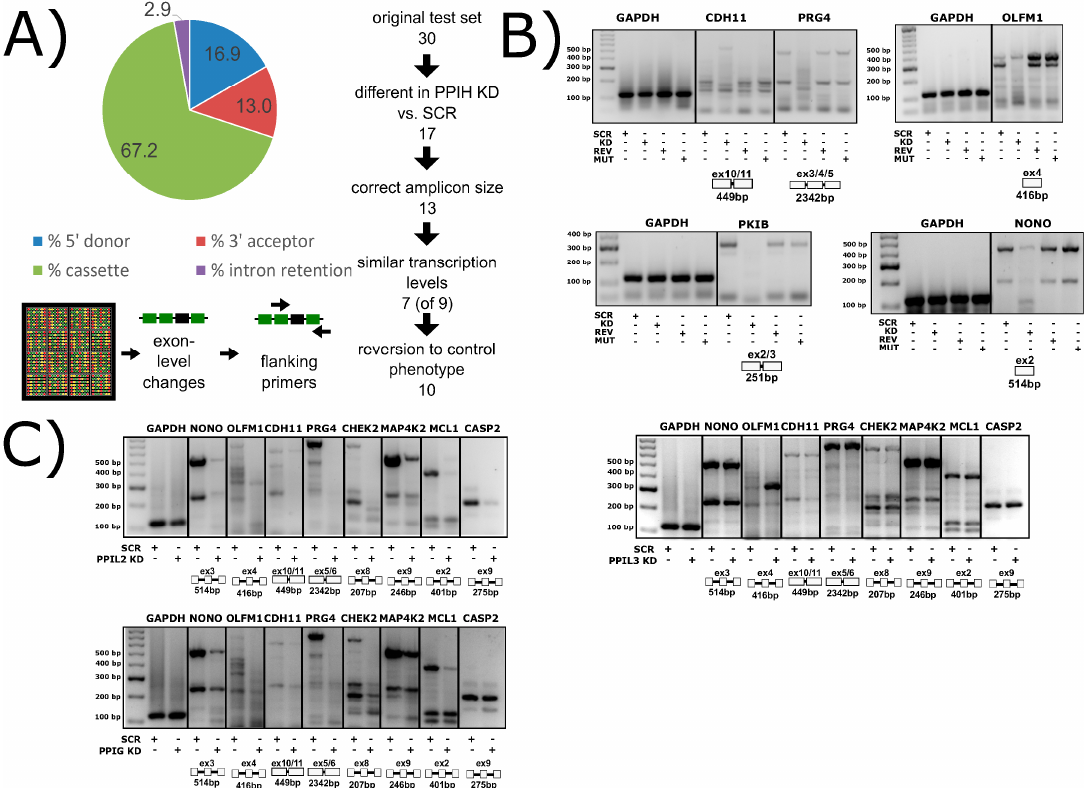
Figure 12. Spliceophilins impact alternative splicing patterns in human cells. ( A ) Knockdown of PPIH using RNAi results in changes in cassette exon, 5 ′ and 3 ′ splice sites, and intron retention, as measured by the Affymatrix HTA 2.0 array. ( B ) Compared to control cells (SCR, scrambled RNAi), PPIH knockdown cells (KD, PPIH-specific RNAi) exhibit altered alternative splicing of multiple genes (labeled at top of gels). Methods are summarized in Appendix B. When full-length PPIH is transiently expressed in knockdown cells (REV, PPIH ectopic expression), the splicing changes are reversed. When the W133A mutant of PPIH (MUT, PPIH mutant ectopic expression) is transiently expressed, the KD phenotype is seen, indicating that isomerase activity is dispensable for this function. ( C ) The knockdown of PPIL2 exhibits splicing patterns identical to that of PPIH knockdown, while PPIG only regulates a subset of genes, and PPIL3 does not regulate any of the common targets tested. Not shown,